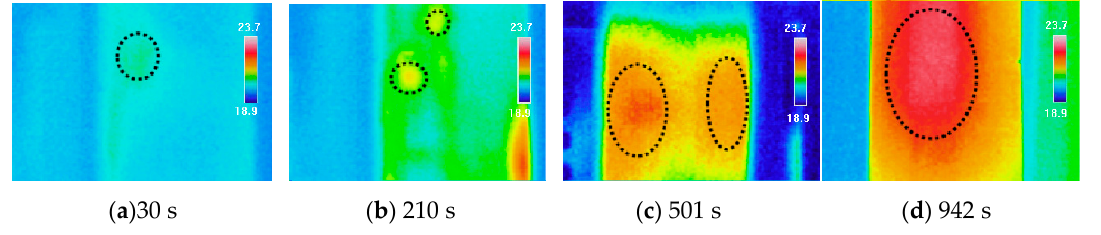
Figure 5. Thermal images of specimen A2 at different moments.